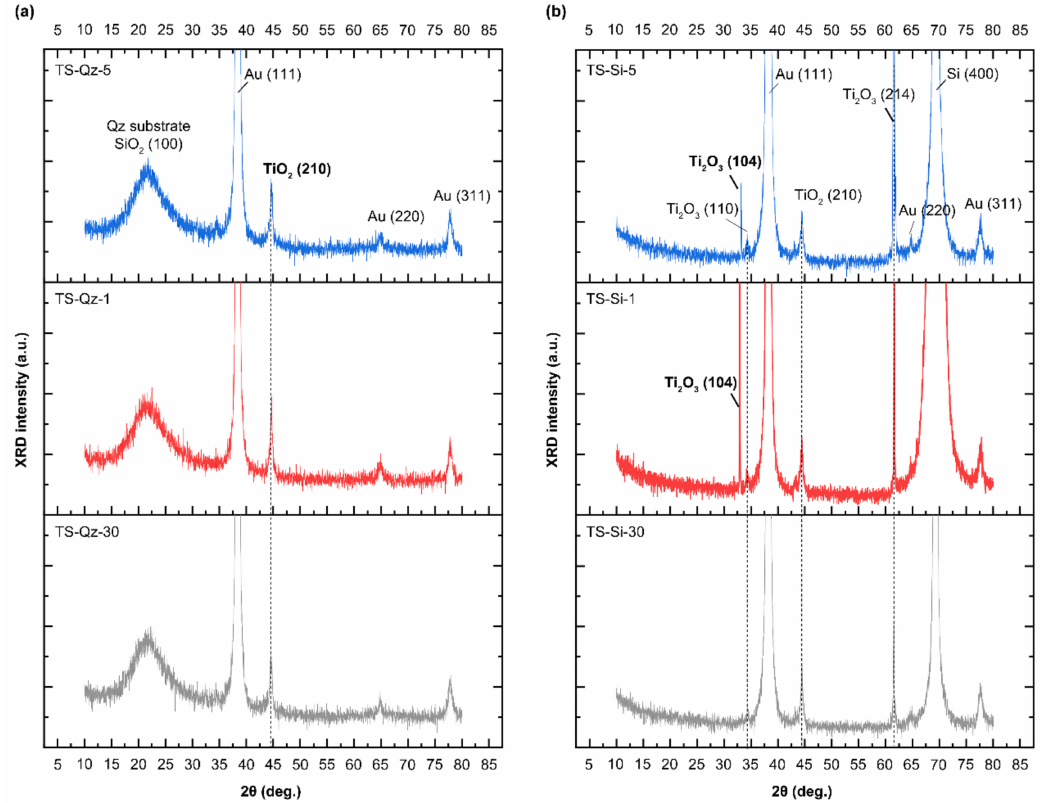
Figure 2. X-ray diffraction (XRD) of TiO 2 /SiO 2 on the quartz glass (Qz) ( a ) and Si ( b )